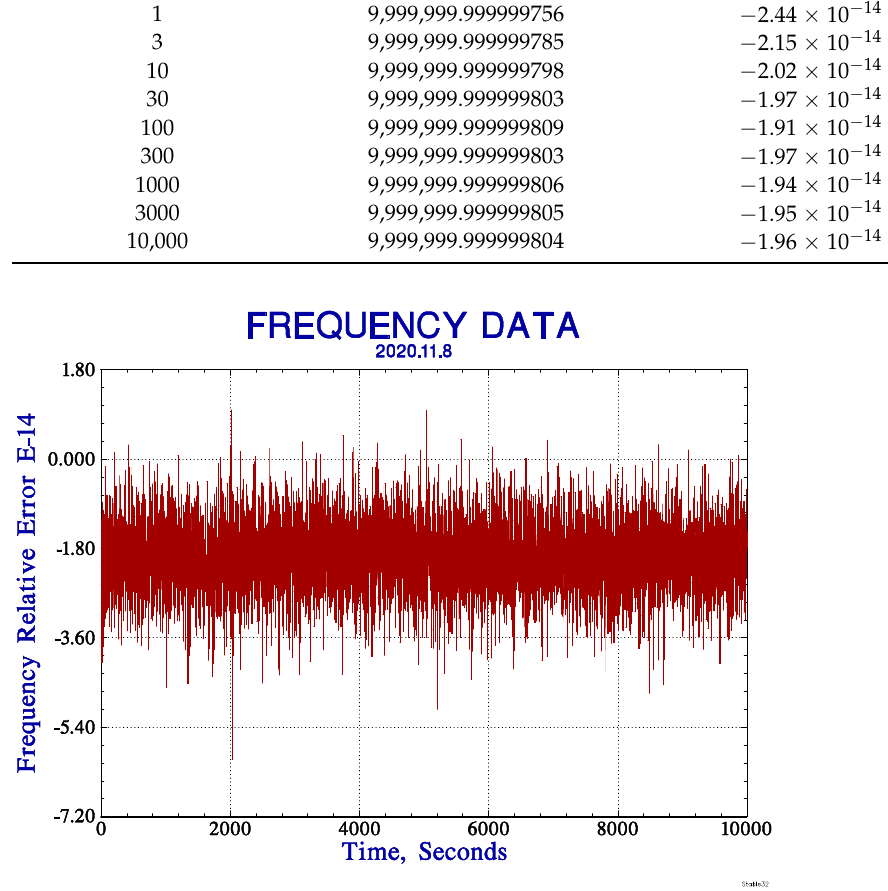
Figure 8. The frequency relative error during the continuous measurement of 10,000 s.